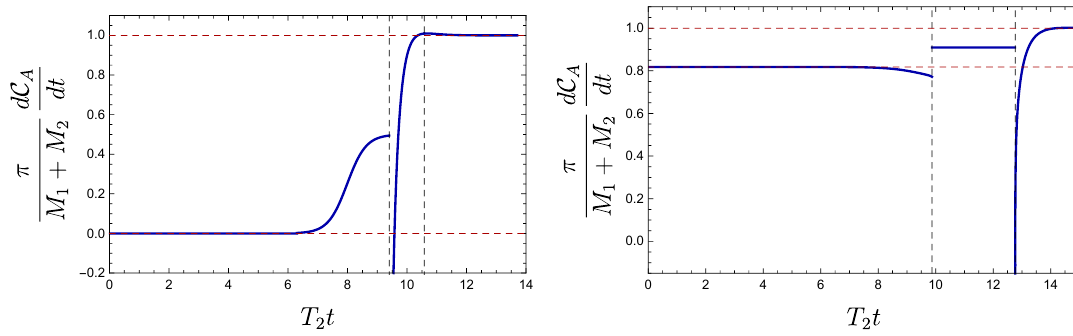
Figure 29. Complexity growth rate for AdS 5 spherical ( k = 1) black hole with z = 1 =w , t w = 6 =T 2 and ~ ‘ ct = 1, light shock wave w = 1+10 (cid:0) 4 to the left and heavy shock wave w = 2 to the right. For the heavy shock wave, r b disappears into the future singularity before r m emerges from the past singularity. Around t = 0, there is a long plateau where the rate is ( M 2 M 1 ) =(cid:25) (indicated by the (cid:0) lower dashed horizontal line). For the heavy shock wave, there is a transient regime ( t c 2 < t < t c 1 ) where the rate is approximately constant and given by M 2 =(cid:25) . In both examples, when r m emerges from the past singularity (right dashed vertical line), there is a sharp negative peak, then the late time limit of ( M 2 + M 1 ) =(cid:25) is approached from above (upper dashed horizontal line). of the CFT in the thermo(cid:12)eld double state). 49 Using the CA proposal with d = 4